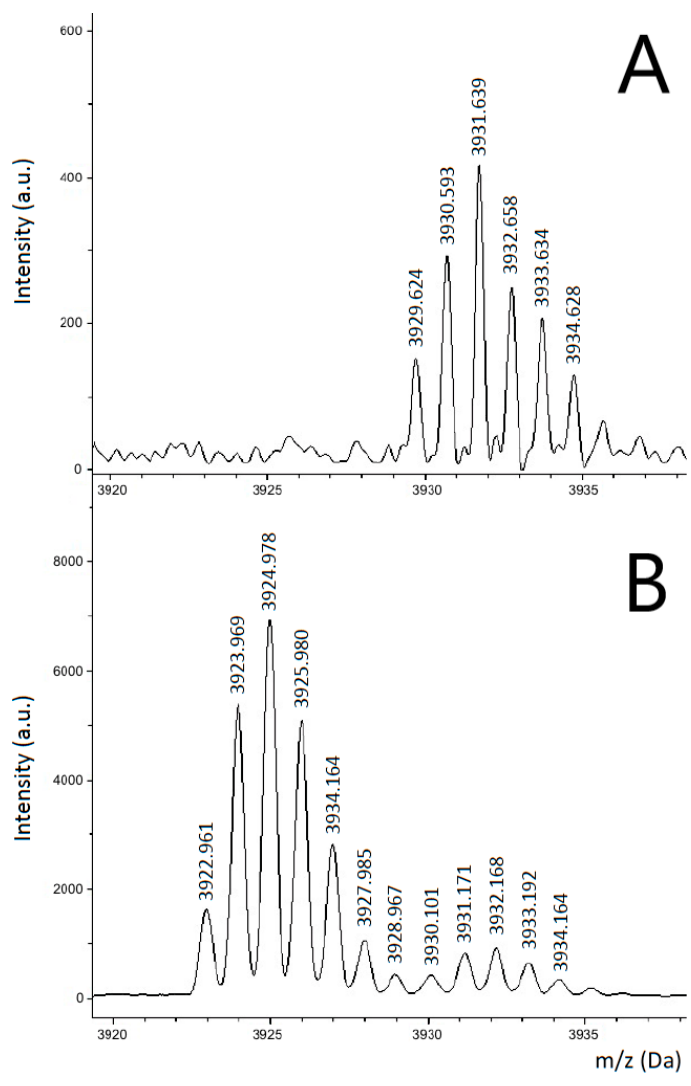
Figure 6. MALDI mass spectra of gelsolin tryptic digest according to in-tube standard procedure ( A ) in comparison to the digest of the same sample carried out on-chip ( B ). The peptide peak structure at m / z of 3921.267 Da is visible in the on-chip digested sample, while it cannot be detected in the in-vial digested sample. This peak structure corresponds to the sequence ATEVPVSWESFNNG D CFILDLGNDIYQWCGSSSNR, which includes the mutation site of D/N 187.